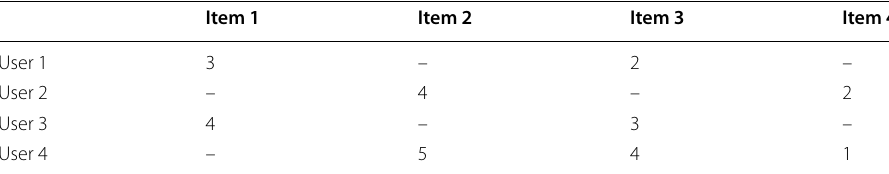
Item 1 Item 2 Item 3 Item